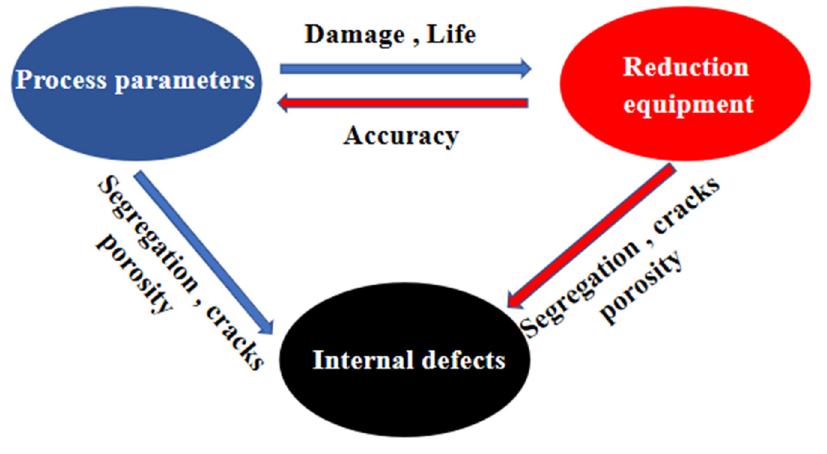
Figure 5. Relationship between reduction parameters, equipment, and casting defects.